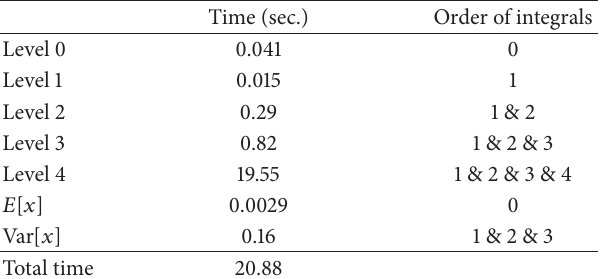
Table 4: The computing time for each level and for the response mean and variance compared with the total